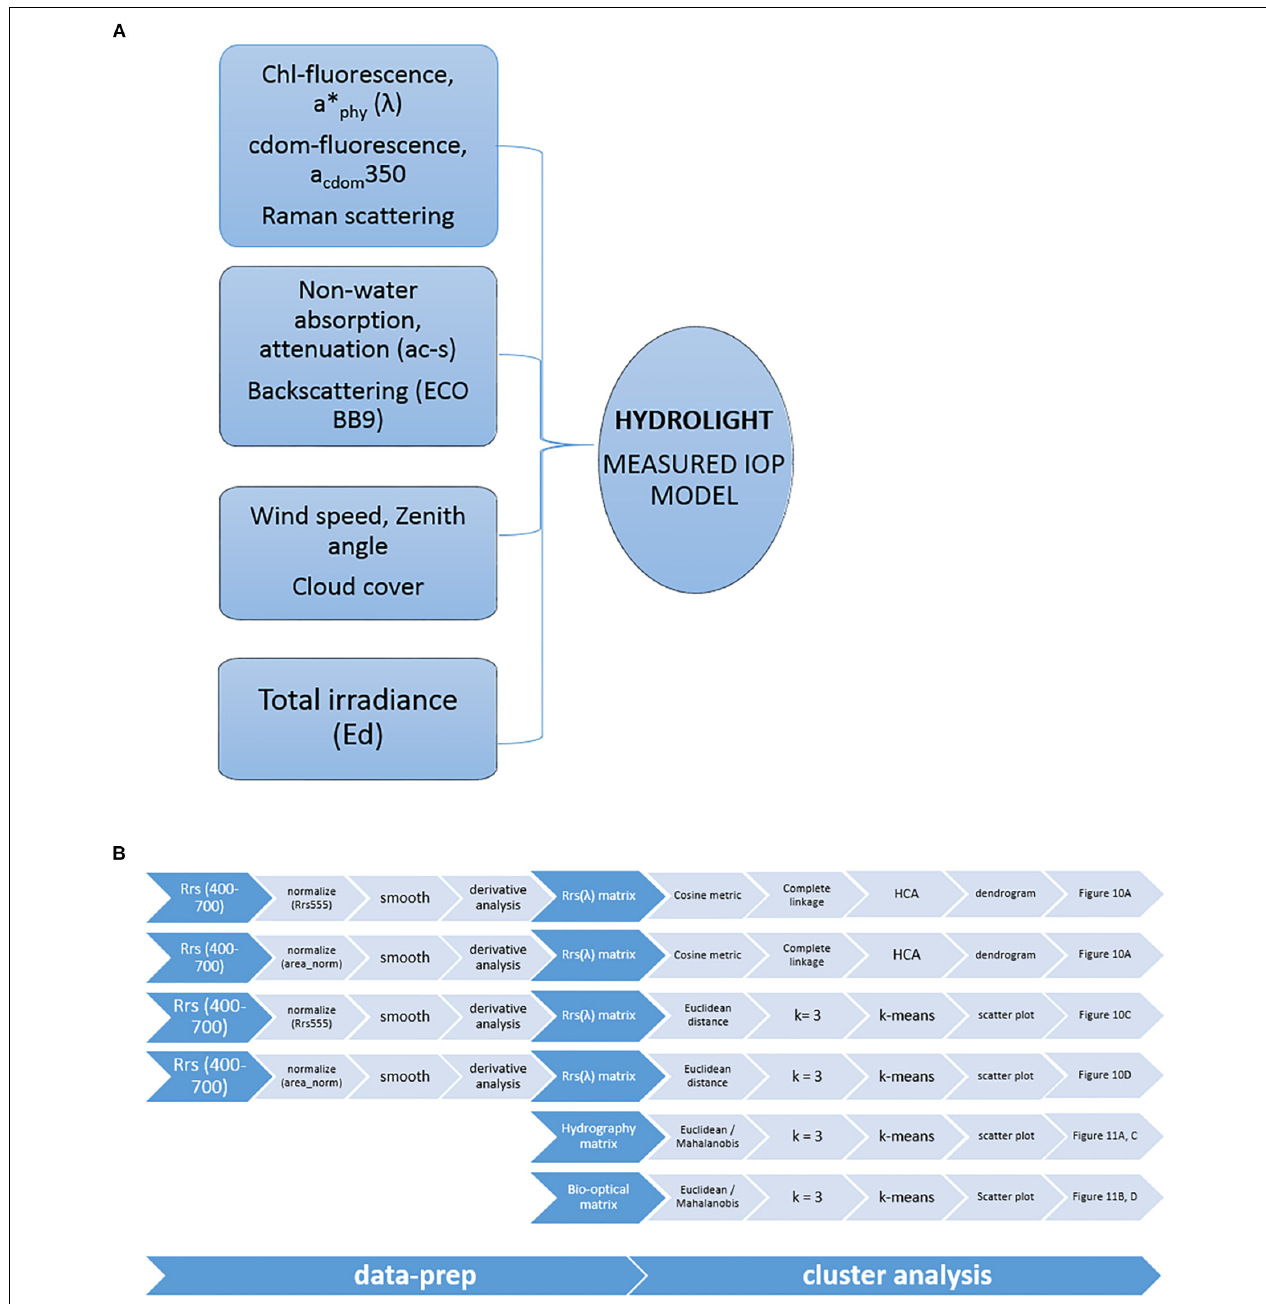
FIGURE 2 | (A) Schematic of the radiative transfer model simulations in Hydrolight. For details, refer to section “Radiative Transfer Modeling.” (B) Schematic of cluster analysis of hydrographic and bio-optical data in the Vaigat-Disko Bay. For details, refer to section “Derivative and Cluster Analysis.”